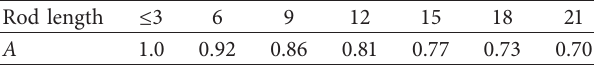
Table 4: Corrected rod parameters [22].